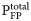
Comparison between estimated and measured rates of misclassified spikes.a. Comparison of estimated rates of false positive spikes (PFPtotal) with actual proportion of false positive error (%FP). Each dot corresponds to the error rate for the single unit matching the ground truth cell spike times. Same symbols and colors as in Fig 3. b. Same as a but for false negative spikes (PFNtotal). c. Same as a but for the total proportion of misclassified spikes (PFPtotal+PFNtotal). Circled symbols correspond to clusters that were not validated as well isolated single units either because SNR was too low (< 4) or their estimated rates of misclassified spikes was too high (PFPtotal+PFNtotal > 20%).